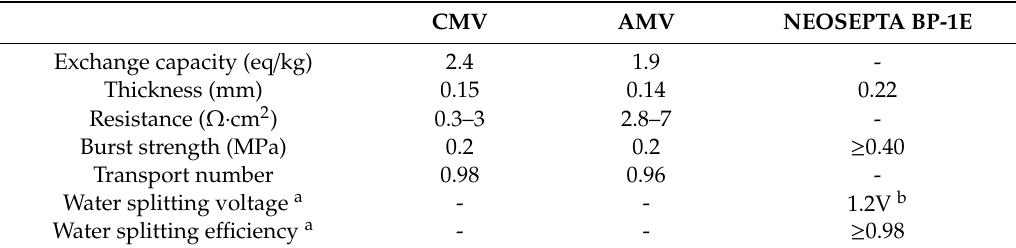
Table 1. The main properties of the membrane during the